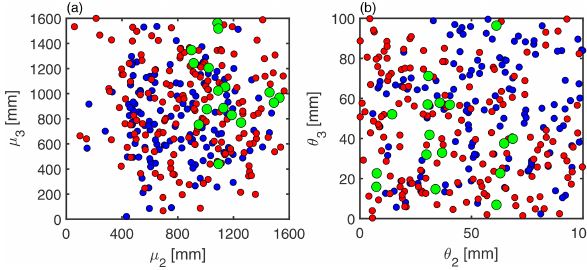
Figure 4. Distributions of SAS function mean ( µ ; a ) and scale ( θ ; b ) behavioral parameters directly controlling the selection of longer travel times by streamflow, constrained by deuterium (148 blue dots) or tritium (181 red dots) or both (16 green